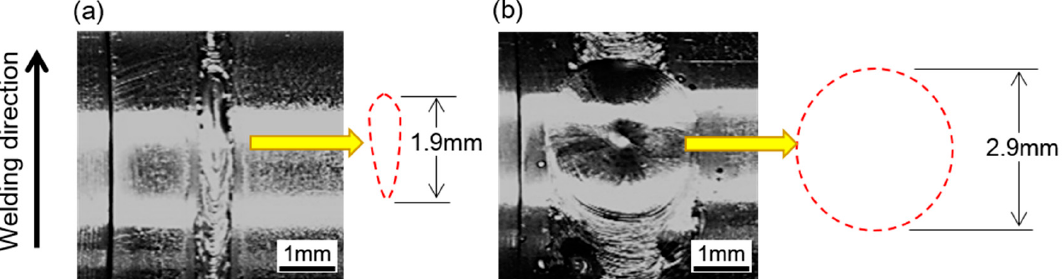
Figure 11. Surface morphology at the end position of: ( a ) Joint 1; ( b ) Joint 2.